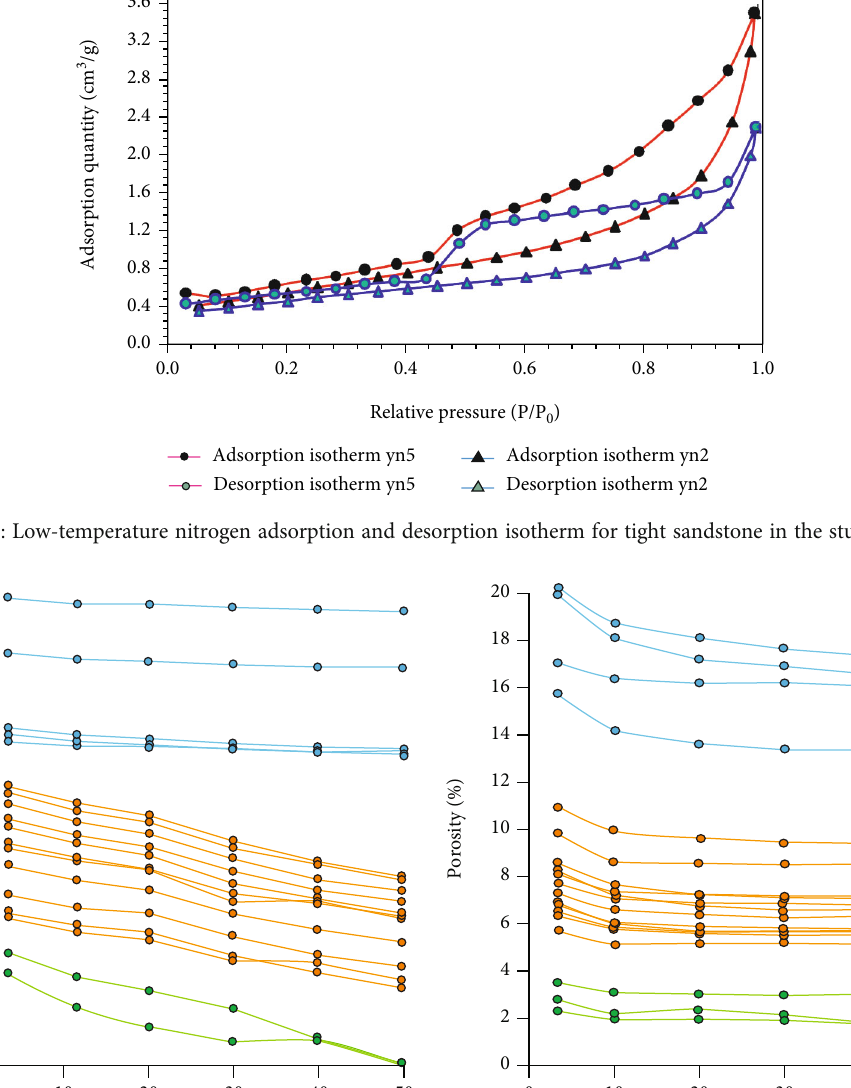
Figure 9: Correlation between porosity and permeability under overburden pressure of tight sandstone samples in the Dibei